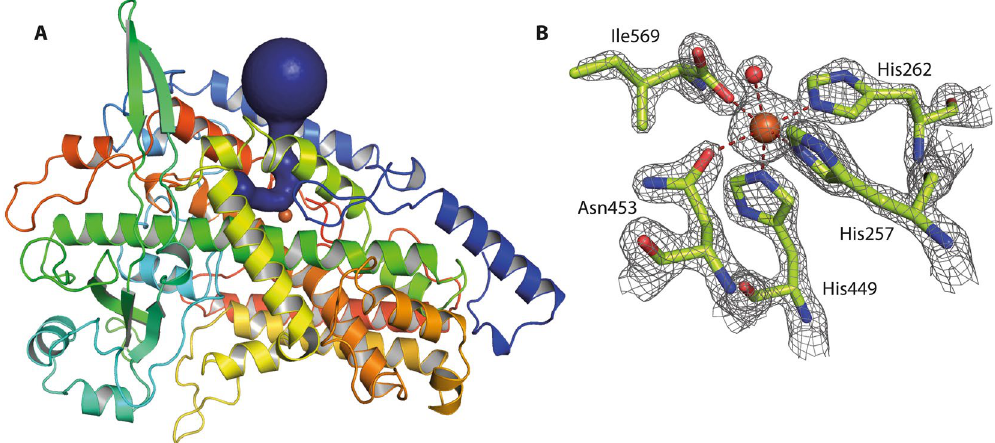
Figure 1. Structure of CspLOX2. ( A ) The overall structure of CspLOX2 is depicted with its putative substrate- binding channel calculated by Caver 3.0 shown in blue and the catalytic iron as orange sphere. ( B ) The catalytic iron is coordinated by five amino acids and a water/hydroxide in an octahedral geometry. The 2mFo-DFc electron density map is contoured at 4 σ . The red dashed lines highlight coordination geometry of the metal